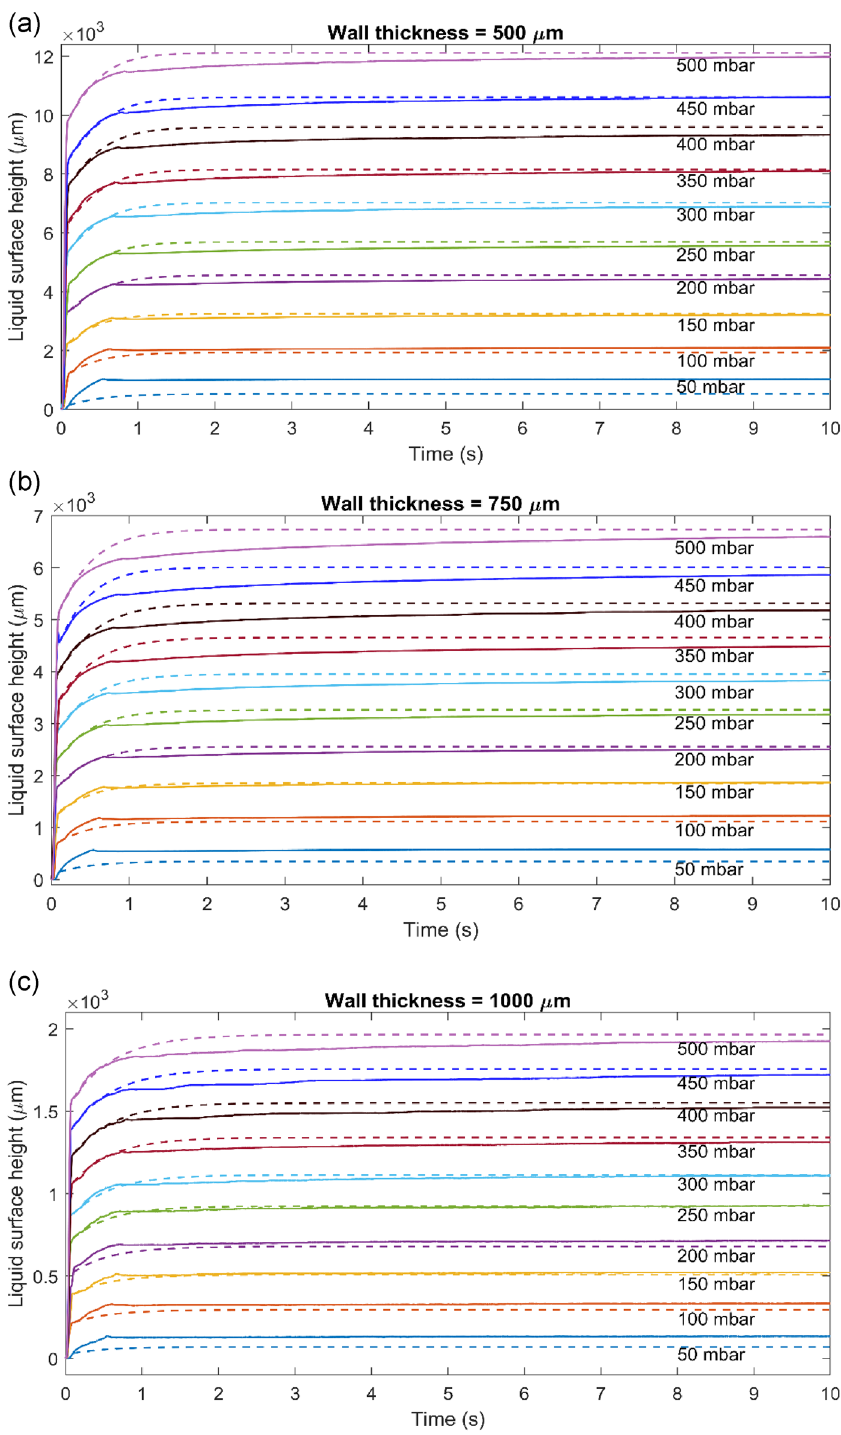
Figure 4. Experimental trials (solid lines) overlayed with simulated (dashed lines) theoretical model for ( a ) 500 µm. ( b ) 750 µm. ( c ) 1000